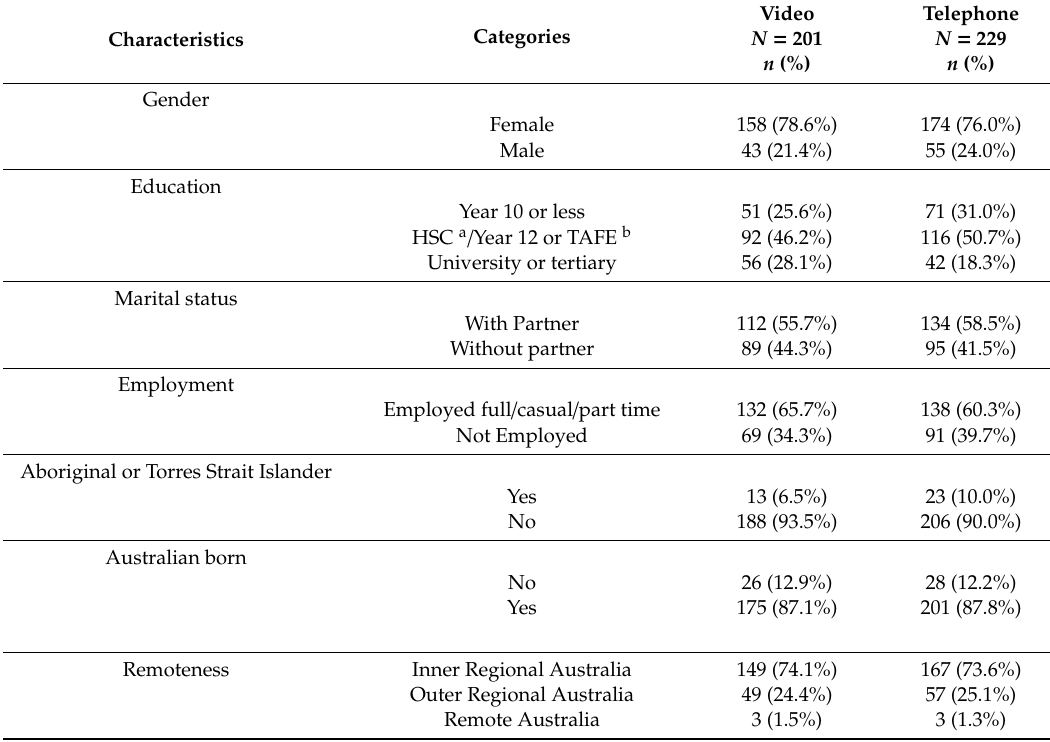
Table 1. Participant characteristics in video and telephone